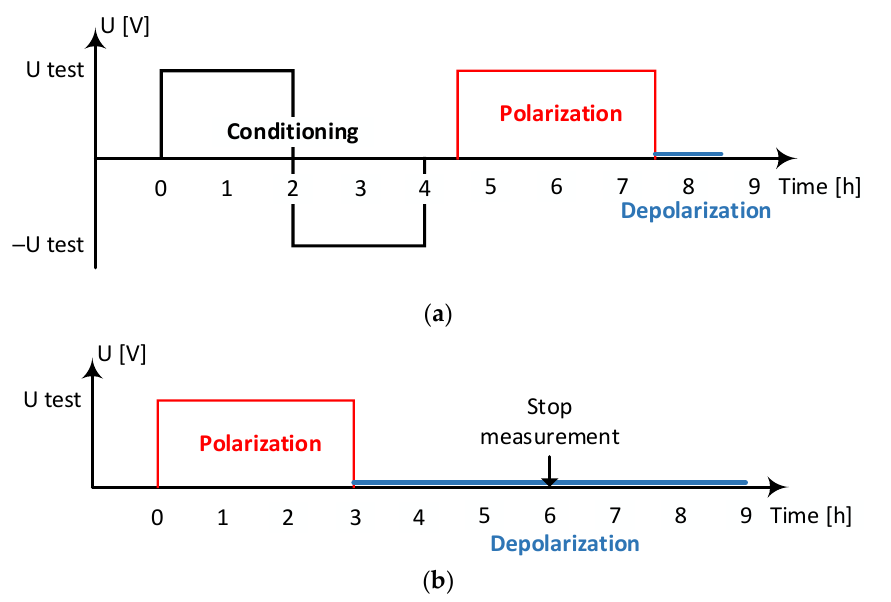
Figure 4. Conditioning and measurement cycle for: ( a ) ester oil; ( b ) ester OIP. Tables 1 and 2 summarize the conductivity measurements results for ester and mineral oils/OIPs whereas Figure 5 presents them graphically. Table 1. Conductivity measurement results for mineral oil/OIP and their conductivities ratio (CR). 1 kV/mm 3 kV/mm